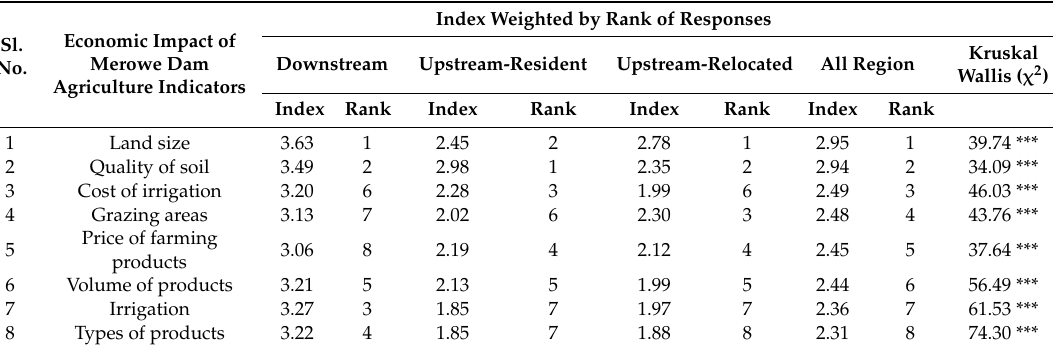
Table 4. Ranking of farming relating economic indicators by